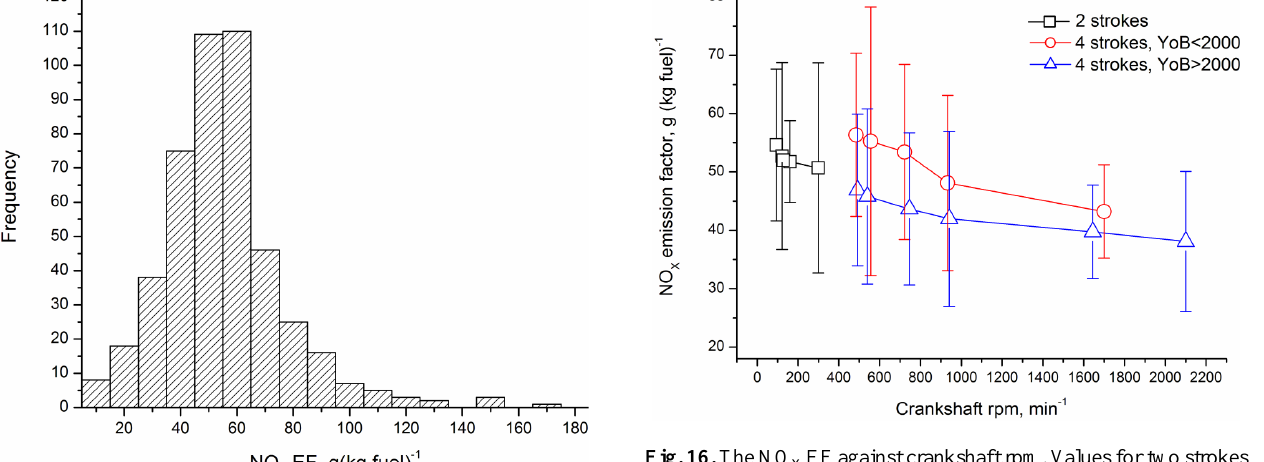
Fig. 16. The NO x EF against crankshaft rpm. Values for two strokes Figure 16. The NO X EF against crankshaft rpm. Values for two strokes engines and 1043 engines and four strokes engines built before and after year 2000 four strokes engines built before and after year 2000 were plotted in different colours. 1044 were plotted in different colours. Error bars refer the standard devi- Error bars refer the standard deviations of NO X EF in RPM bins. NO X EF values are 1045 ations of NO x EF in RPM bins. NO x EF values are represented as NO 2 represented as NO 2 equivalent. 1046 1047